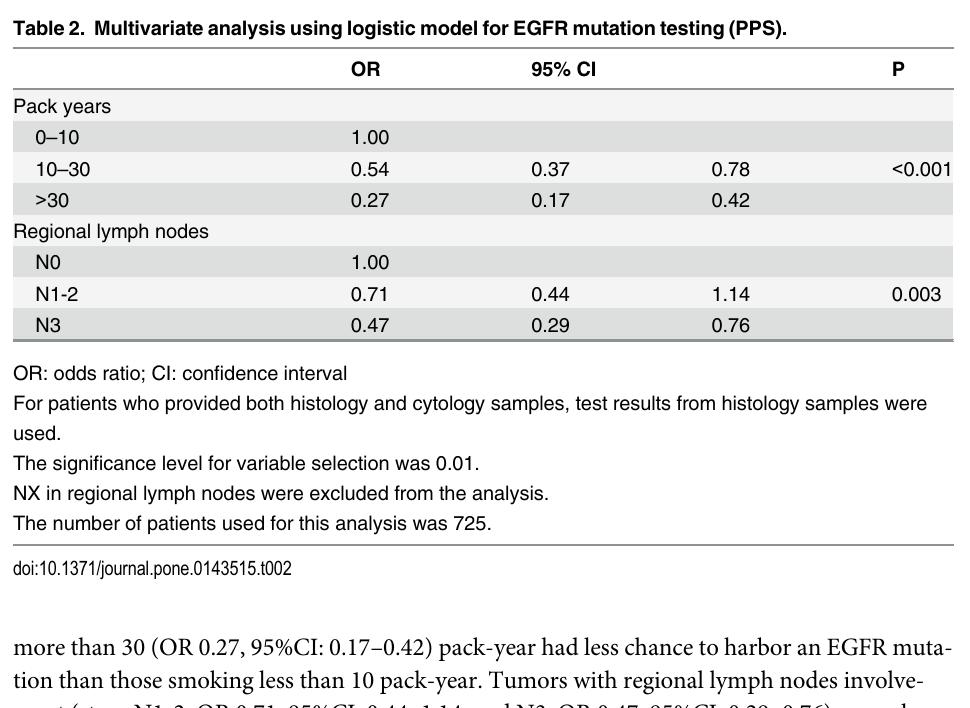
Table 2. Multivariate analysis using logistic model for EGFR mutation testing (PPS). OR 95% CI P